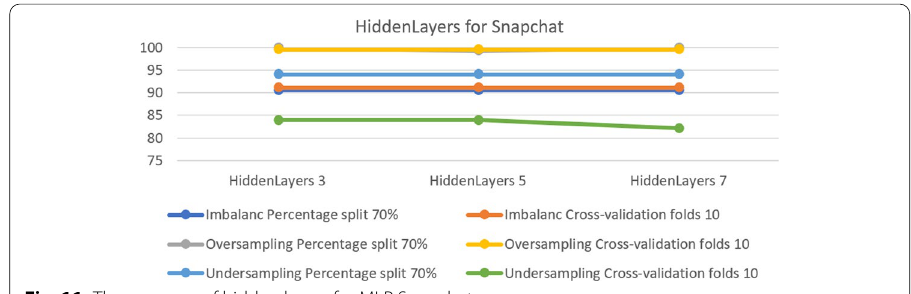
Fig. 11 The accuracy of hidden layers for MLP Snapchat